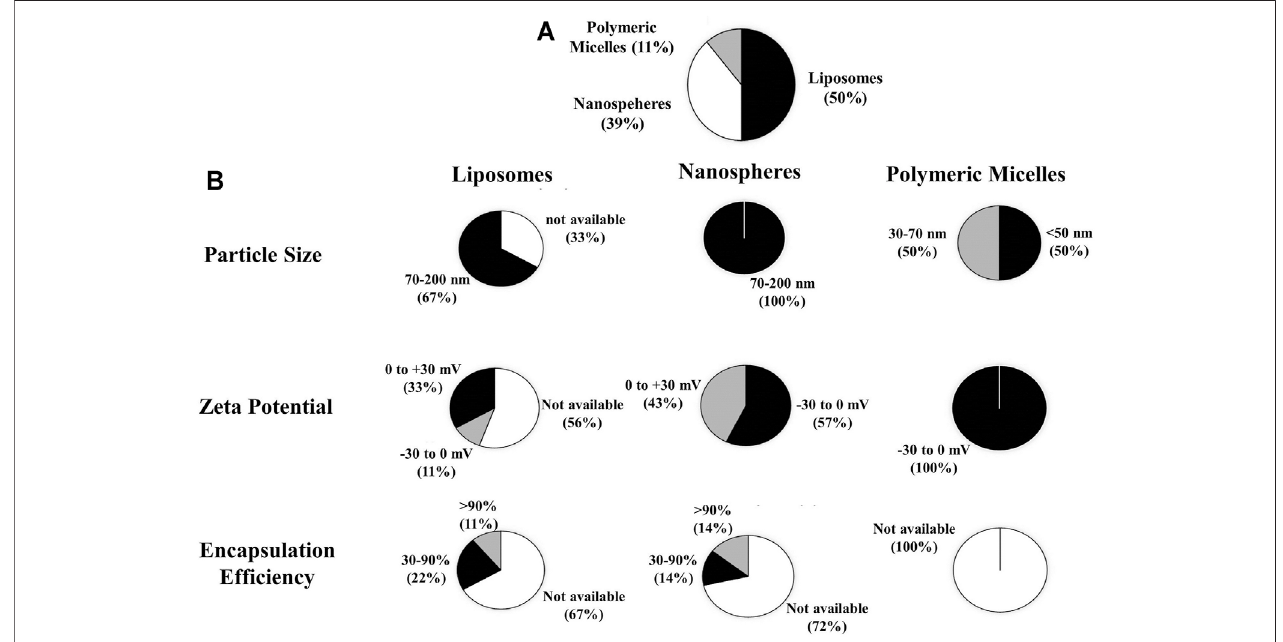
FIGURE 2 | (A) Types of drug carrier extracted from the article review regarding the preclinical and clinical studies of nanoparticle use for UA delivery within cancer therapy, (B) the physical characteristics of UA-loaded nanoparticles including particle size, zeta potential, and ef fi ciency of encapsulation.